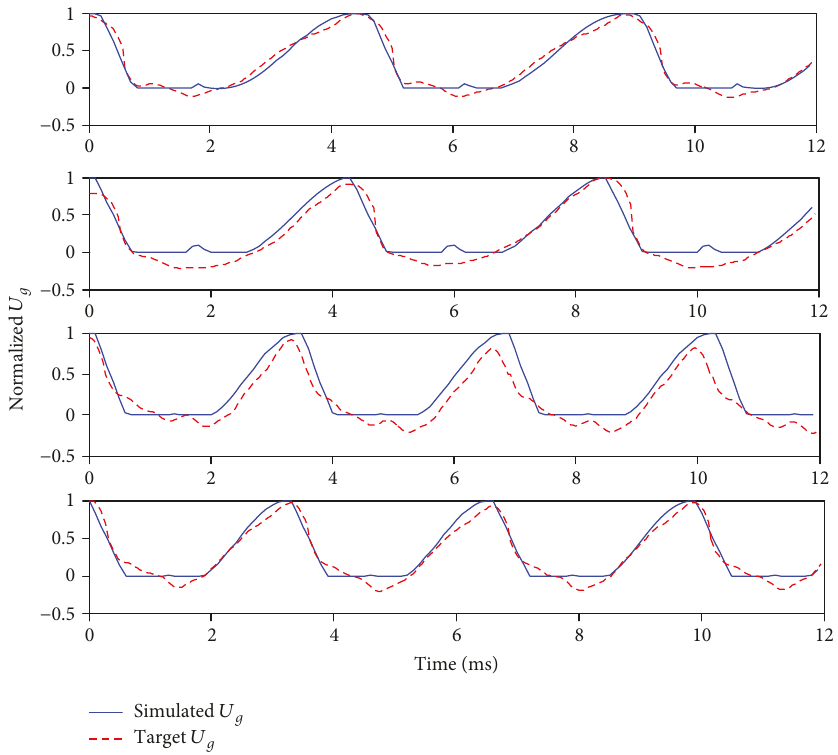
Figure 9: Matching result of normal voice source in the time domain.